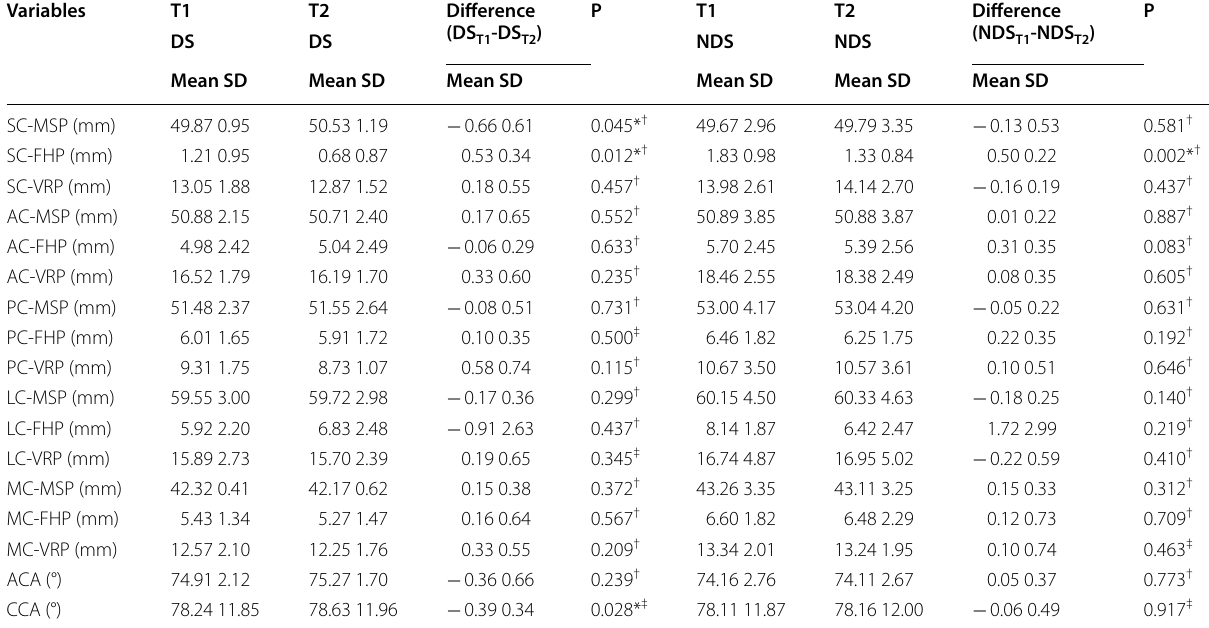
DS, deviated side; NDS, non-deviated side; *indicates a statistical significance at P < 0.05. † paired t test; ‡ Wilcoxon signed rank test